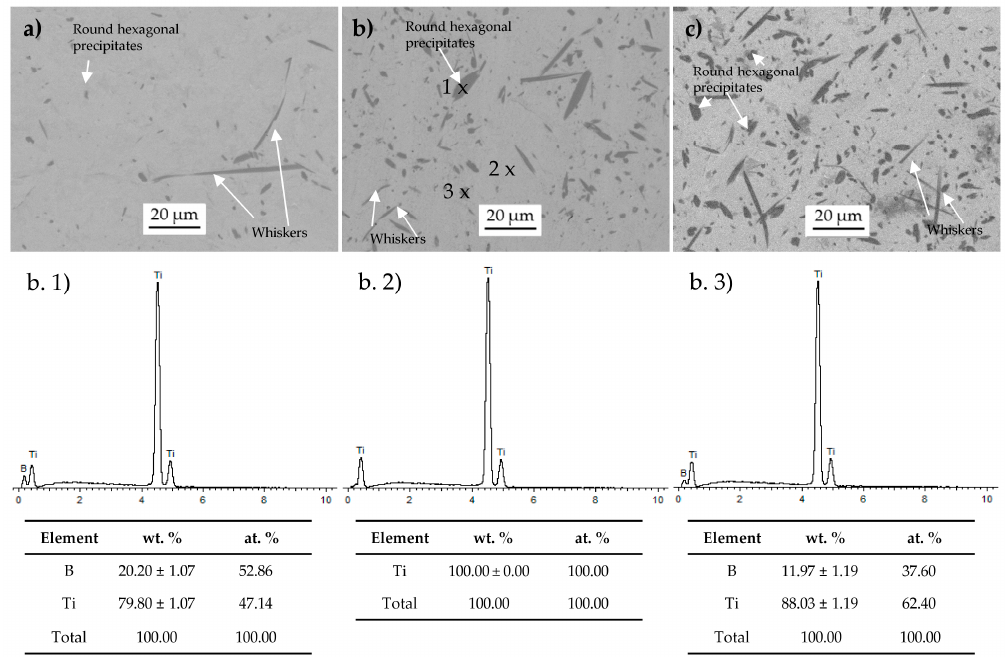
Figure 2. Scanning electron microscope (SEM) images of TMCs manufactured at 1100 °C with different content of amorphous B in their starting powders: ( a ) 0.9 vol %; ( b ) 2.5 vol %; and ( c ) 5 vol %; ( b1 ) EDS spectra spot (1); ( b2 ) EDS spectra spot (2); and ( b3 ) EDS spectra spot (3).